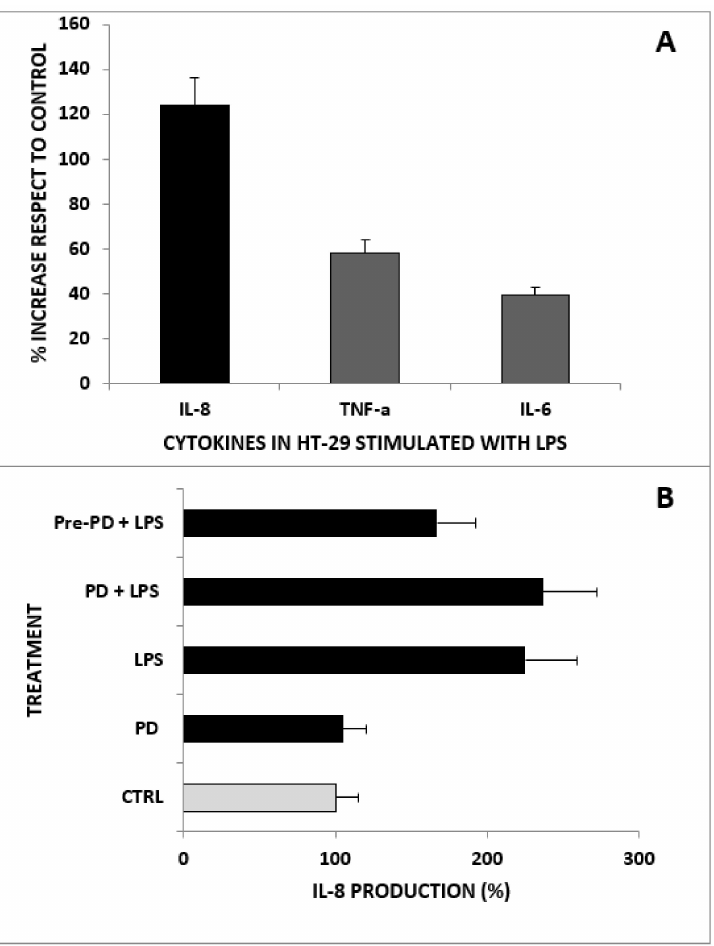
Figure 4. Cytokine production by LPS-stimulated HT29 cells. ( A ) Proinflammatory cytokine pro- duction (IL-8, IL-6, and TNF- α ) by HT-29 cells treated with LPS (1 µ g/mL) for 16 h. Results are expressed in terms of the percentage increase in cytokine production with respect to untreated HT-29 (controls). Data are expressed as the mean of three independent experiments. Bars represent the SE of the percentages. ( B ) IL-8 production by HT-29 cells treated with LPS and/or PD. The treatments were performed with LPS (1 µ g/mL), PD (5 µ g/mL), PD (5 µ g/mL) before LPS (1 µ g/mL), or PD (5 µ g/mL) plus LPS (1 µ g/mL). Results are expressed in terms of the percentage of cytokine produc- tion with respect to untreated HT-29 controls. Data are expressed as the mean of three independent experiments. Bars represent the SE of the percentages. Pre-PD + LPS is significantly ( p < 0.05) lower than PD +